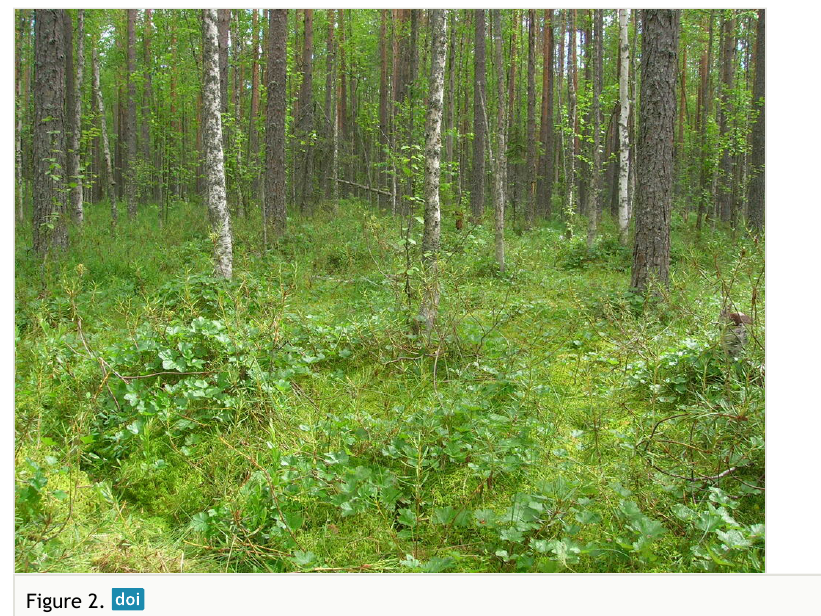
Typical plant communities of the Ustya local flora (Arkhangelsk Oblast, Russia): small peat bog (Oxycocco-Sphagnetea) in taiga forest (Vaccinio-Piceetea). Photo by Irina P. Seregina (2006).